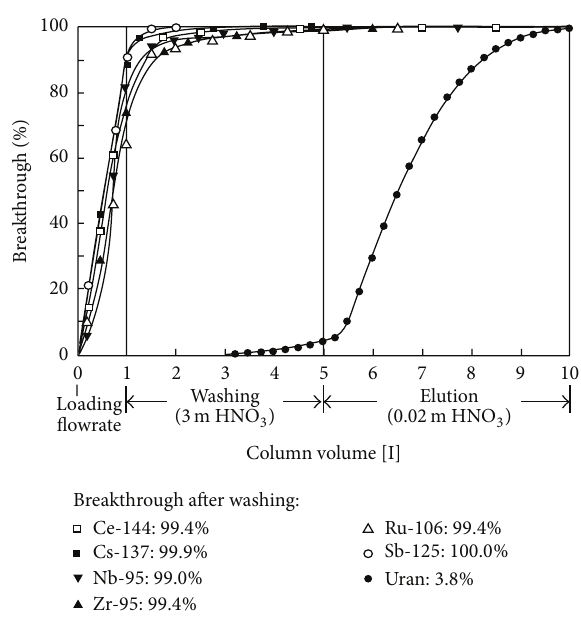
Figure 10: Decontamination of uranium from fission product spe- cies on TBP loaded SM-7